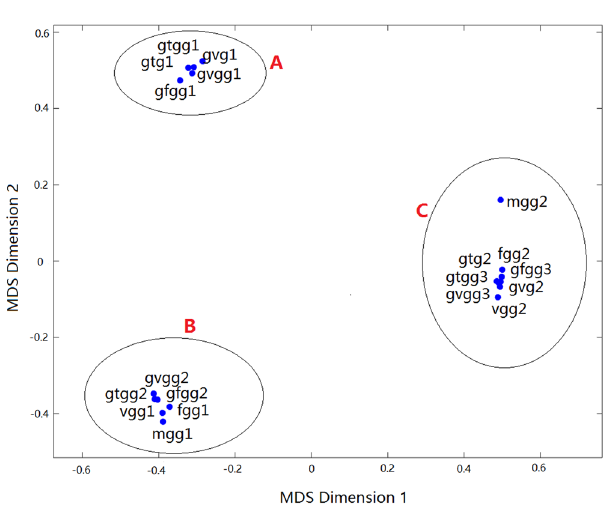
Figure 2. 2D MDS map of all ϕ - ψ units in the low-energy conformations of 8